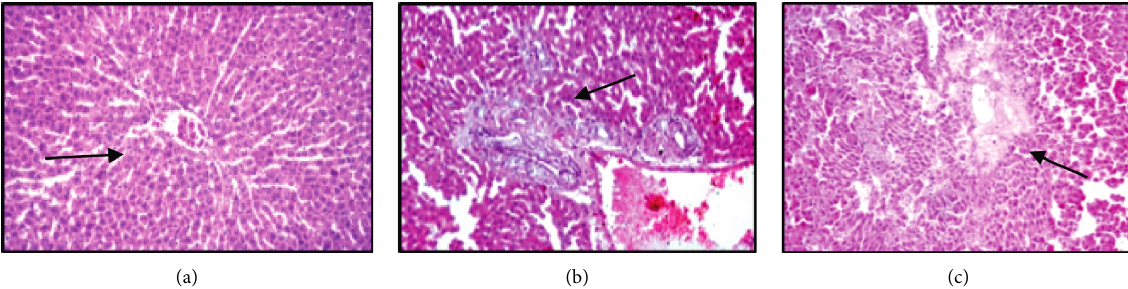
Figure 3: Histological structure of the liver; staining with hematoxylin and eosin. (a) Intact group: the grinder structure of the hepatic lobules is preserved, moderate plethora of the central vein and moderate expansion of sinusoids, zoom x100; (b) rat liver histology after 90 days after dose of 0.2Gy single irradiation in combination with daily exposure to coal dust for 4hours: in the interlobular stroma of the proliferation of fibrous fibers around the components of the triad and moderate infiltration with lymphocytes and histiocytes, plethora of the dilated vein, zoom x100; (c) rat liver histology after 90 days after dose of 6Gy single irradiation in combination with daily exposure to coal dust for 4 hours: foci of colliquation necrosis in the paracentral zone of the hepatic lobule and discomplexation of the hepatic tracts, zoom